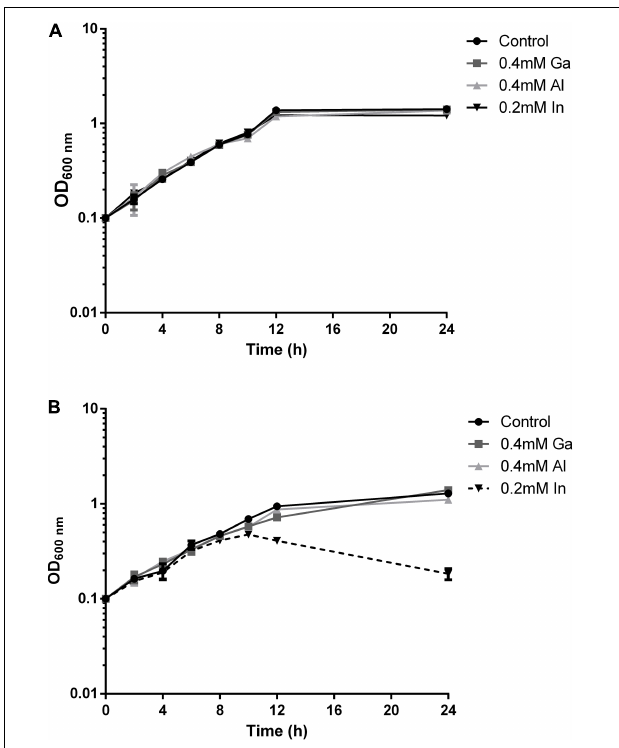
FIGURE 3 | Growth curves of strain B2A1Ga4 (A) and mutant B2 (B) in different conditions: control (without metal), 0.4 mM Ga, 0.4 mM Al, and 0.2 mM In.